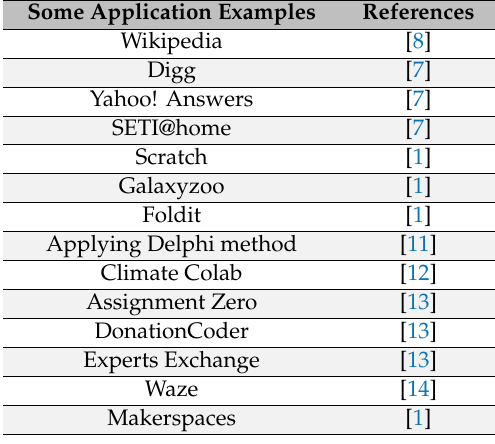
Table 3. Some application examples of mass